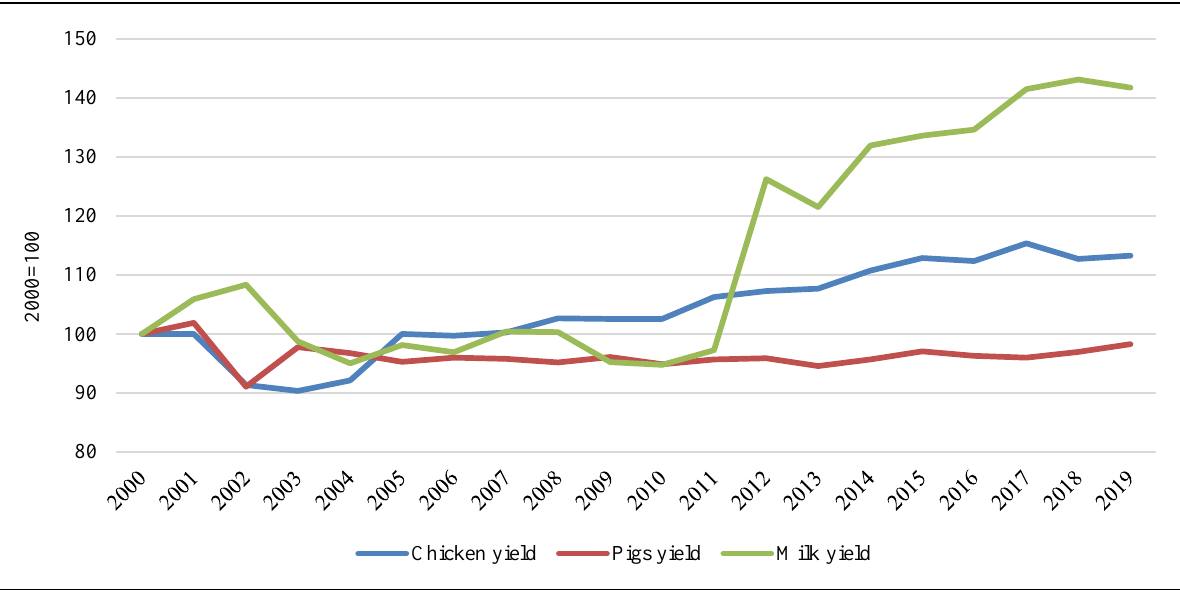
Figure 5. Yield changes of the three major livestock products; Source: Author’s composition based on FAO [27]